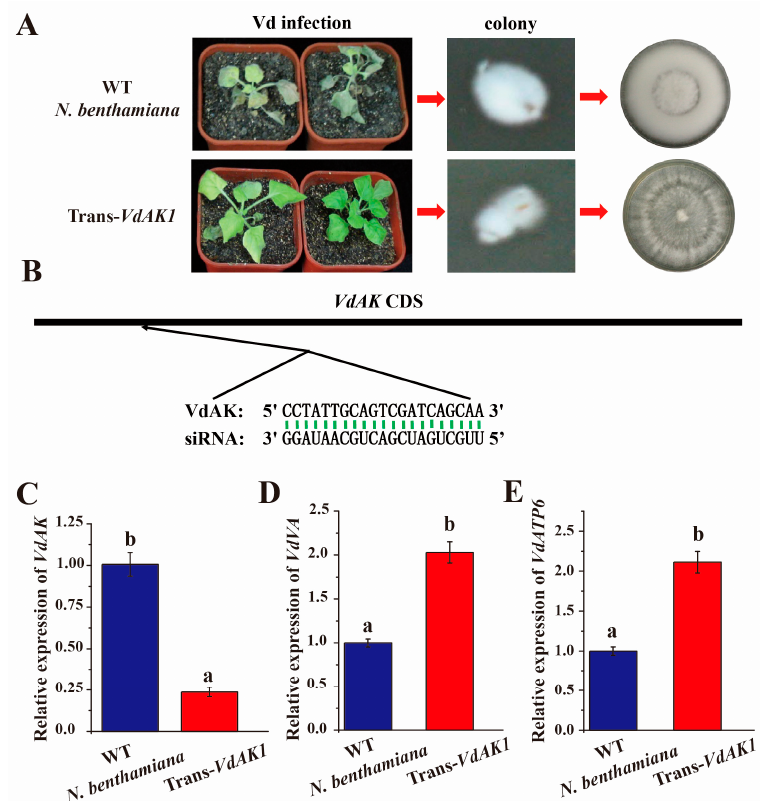
Figure 6. Host-induced gene silencing of VdAK enhanced resistance against V. dahliae ( Vd ). ( A ) Disease symptoms on N. benthamiana at 12 dpi and growth phenotype on PDA of Vd isolated from infected seedlings. ( B ) Specific siRNA targeted the VdAK position. The siRNA sequence aligned with VdAK at the predicted binding site. Relative expression levels of VdAK ( C ), VdVA ( D ), and VdATP6 ( E ) in RT-qPCR analysis of the recovered mycelium. Mean ( ± SE) from three independent experiments that differed significantly in Duncan’s test ( p <0.05) are indicated by different letters.